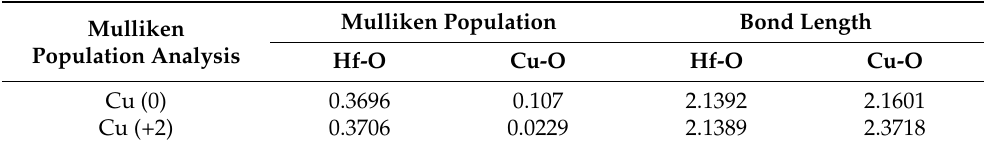
Table 3. Mulliken population analysis.